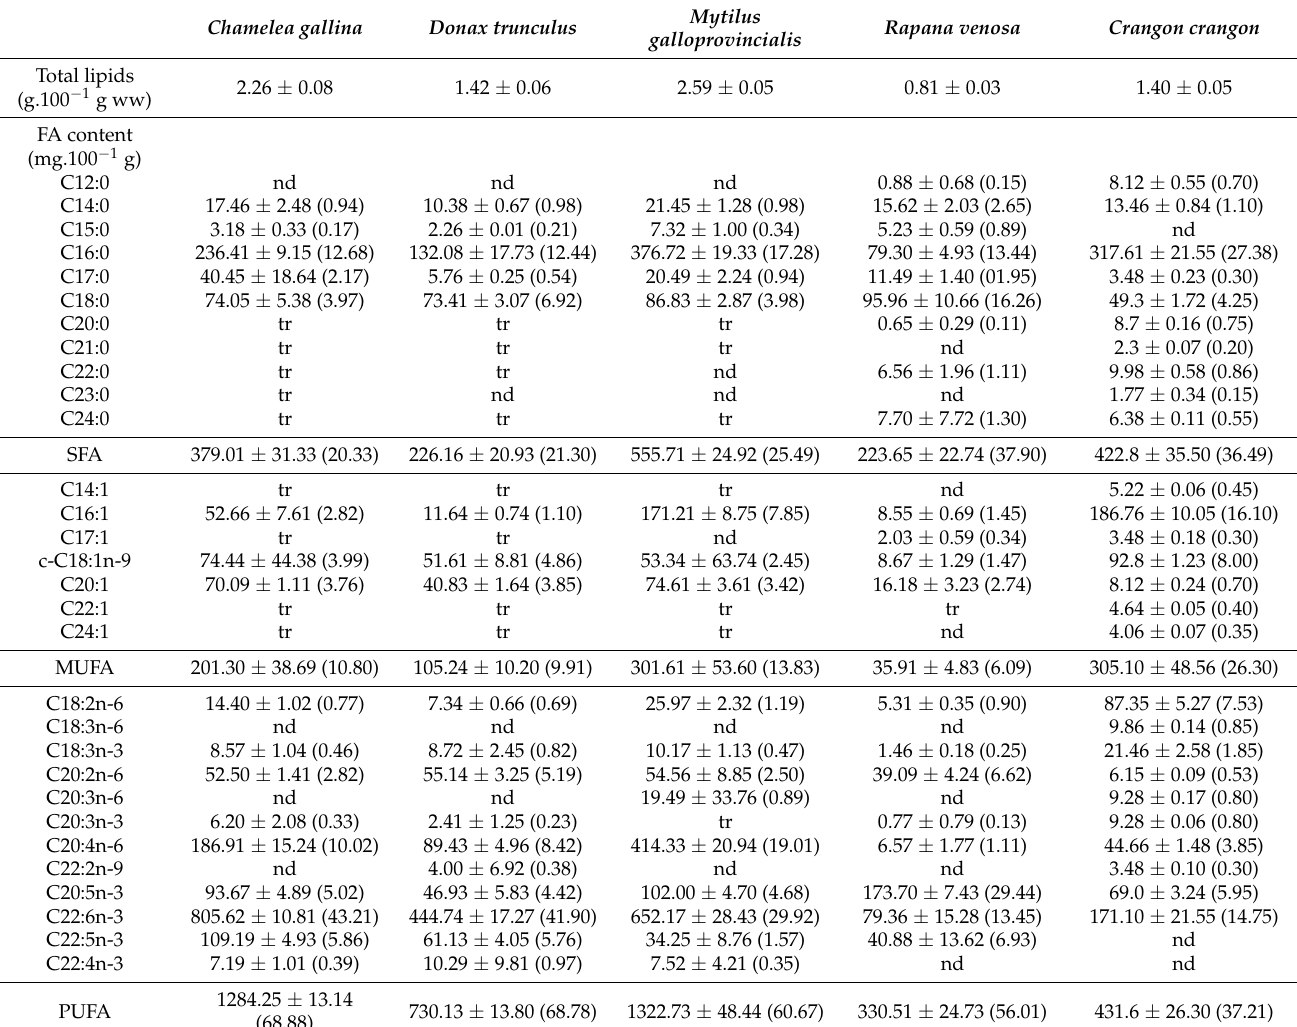
acid (C18:0) is the major SFA in R. venosa (C18:0 > C16:0 > C14:0). Table 4. Total lipids (g/100 g wet weight) and fatty acid composition (mg.100 − 1 g), in the brackets (% of total FAs) of 5 shellfish species from the Black Sea. Mytilus Chamelea gallina Donax trunculus Rapana venosa Crangon galloprovincialis